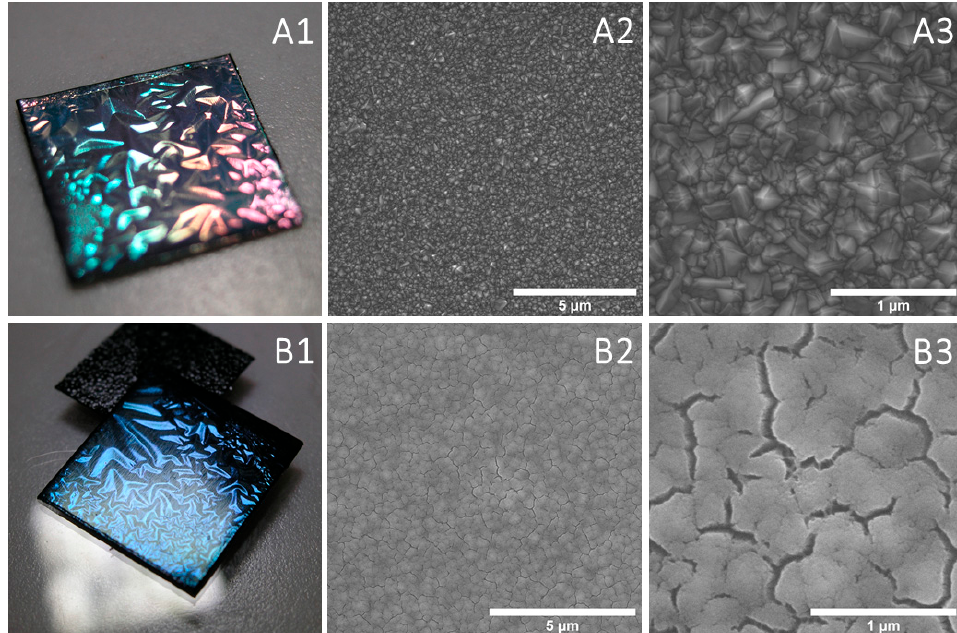
Figure 4. Photographs and SEM images of boron-doped diamond nanosheet on a tantalum substrate ( A1 – A3 ) and coated with nylon ( B1 – B3 ) at various magnifications.